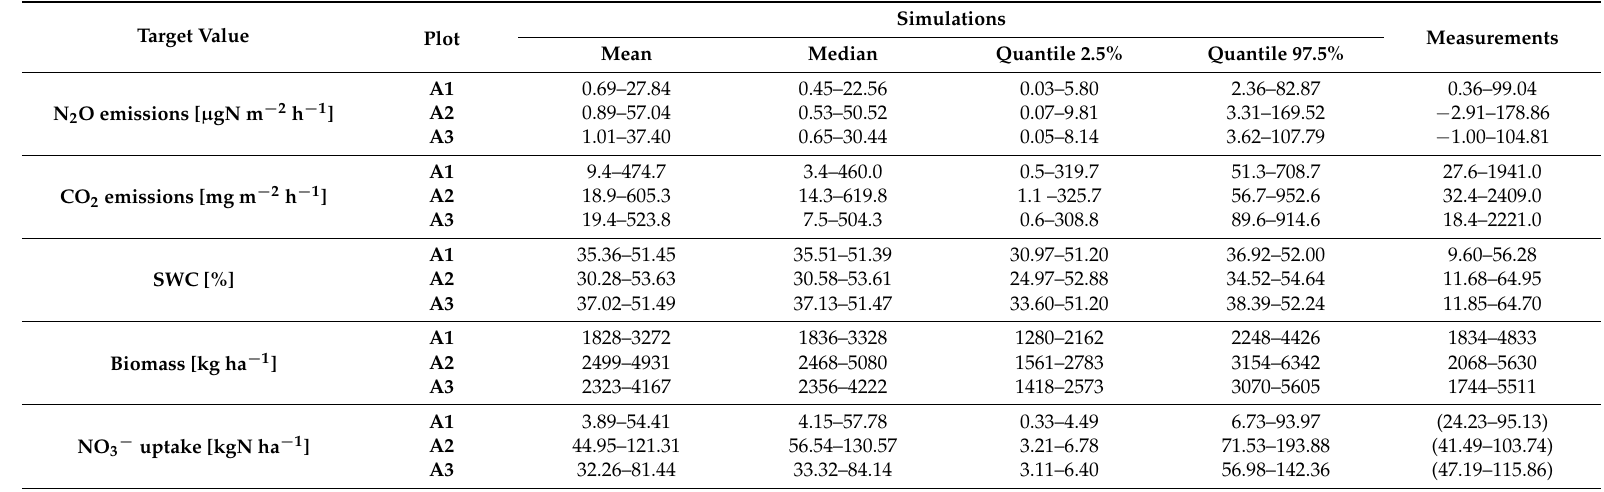
Table A4. Ranges of the statistical characteristics and measured data for withGW simulations during the investigation period. Mean, median and quantiles of the confidence intervals have been calculated for each time point of the period 1997–2009 (1998–2009 for CO 2 emissions). The depicted values show the ranges in which the statistics and measured data varied over time. Round brackets show minimum values for the N deficit calculated from measurements, square brackets show the physical units of the target